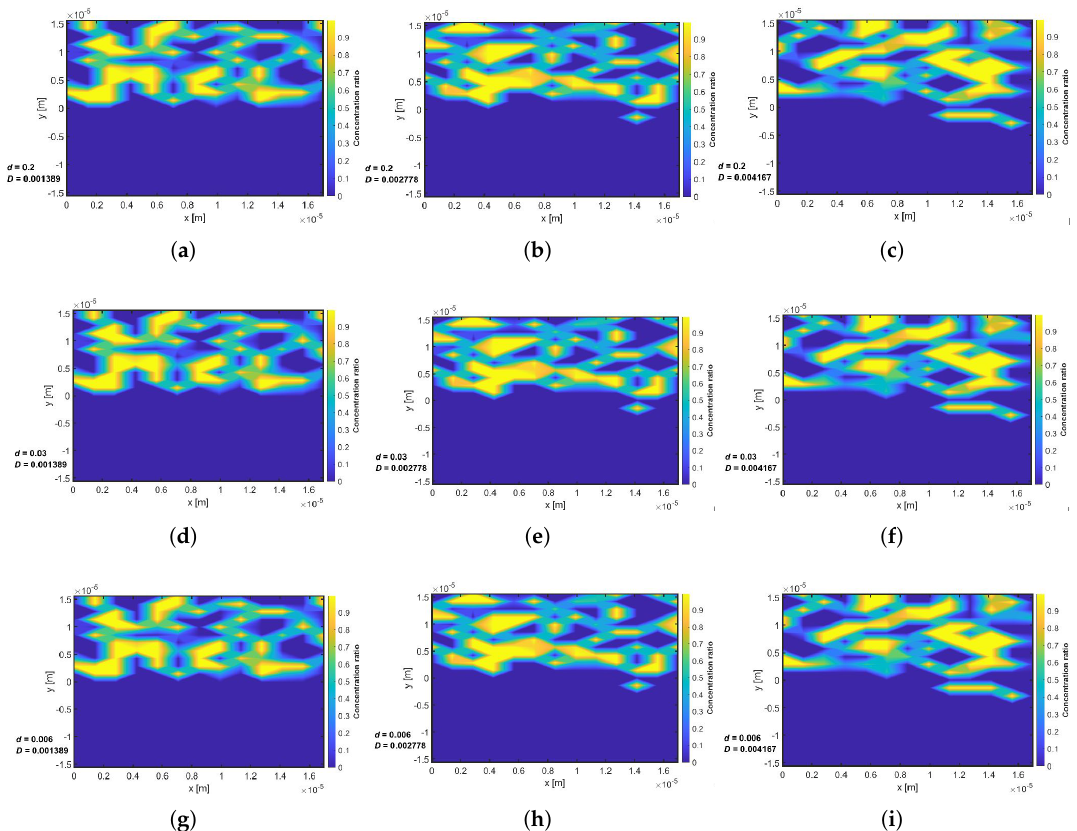
Figure 9. Contour plots of tracer concentration distribution within the porous media with linear drift ratio d = 0.006, 0.03 and 0.2 at 50 days.